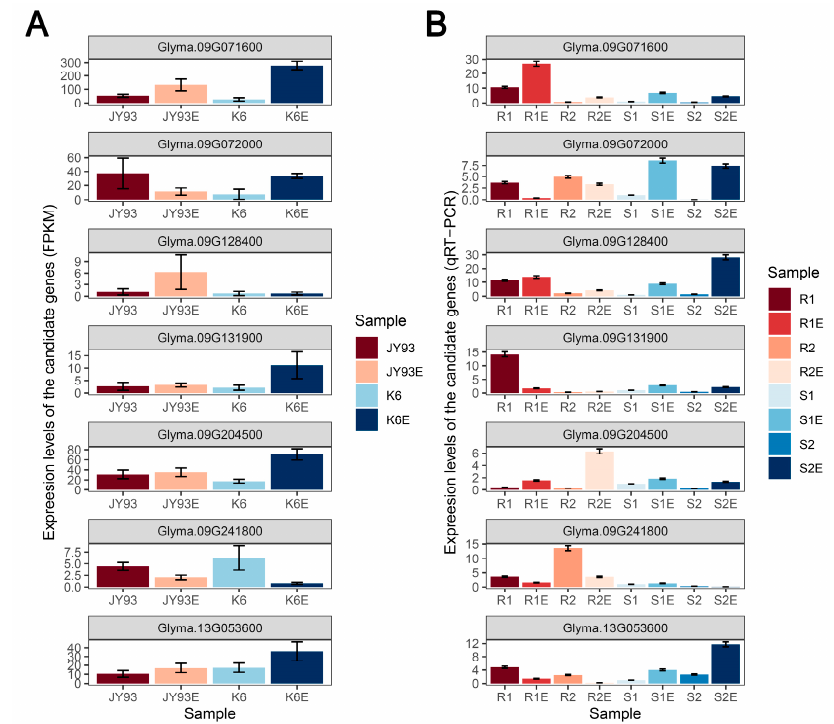
Figure 5. Expression levels of all candidate genes. ( A ) RNA-Seq data of the candidate genes in the mapping parents. The scale on the left indicates the expression levels (FPKM). ( B ) qRT-PCR data of the candidate genes in the four soybean varieties. Among these, two of which were resistant varieties [R1 (ESP = 2.48%, n = 15), R2(ESP = 2.49%, n = 15)] and the other two were susceptible